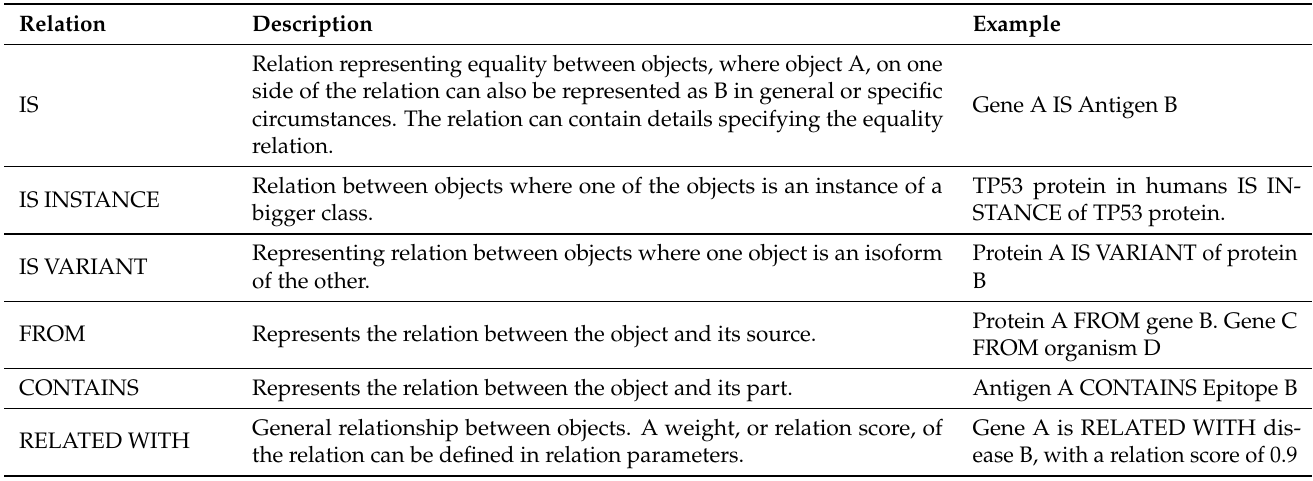
Figure 3. Network of objects from five different sources (DisProt [19], DisGeNET [20], Tantigen 2.0 [21], IEDB [22], and HGNC [23]) represented using the BioGraph model. The example shows protein data collected from DisProt [19] dataset, with identifiers assigned by DisProt and UniProt [24] along with disorder content value. Gene data, collected from HGNC [23] dataset, are connected with protein data from DisProt [19] dataset assigning the gene NCBI [25] identifier. Disease data from DisGeNET [20] are connected to the corresponding gene with an assigned relation score from DisGeNET [20] dataset. Tantigen 2.0 [21] and IEDB [22] datasets add context to the antigen nature of the gene, including information on the epitope of the antigen. Table 2. Base types of the relations between entity